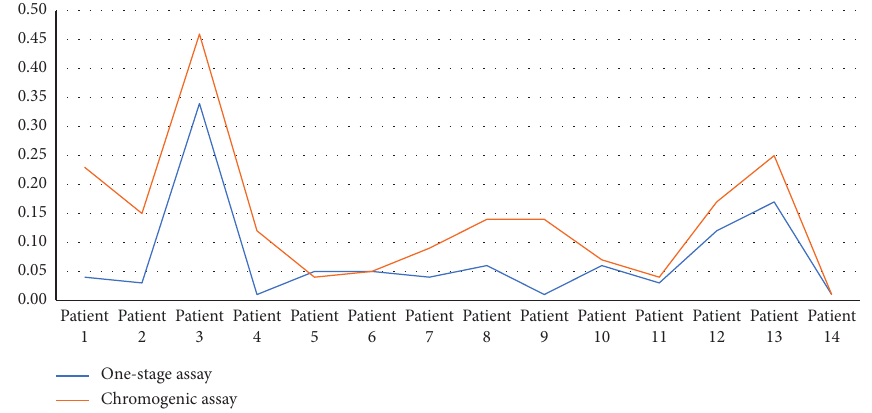
Figure 1: Line chart displaying the mean values of factor VIII levels measured by the one-stage assay and chromogenic assay. Table 1: The comparison between the one-stage assay versus chromogenic assay for the measurement of factor VIII levels in the study population.